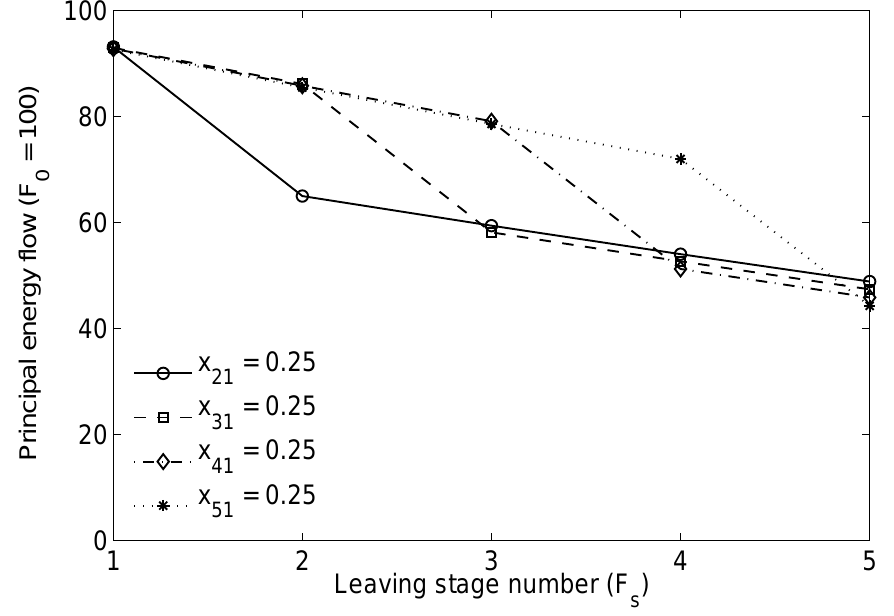
Figure 6. Comparison of final energy output given changes in location of large processing energy input. Note that a processing intensive technology further in the processing chain results in less final energy